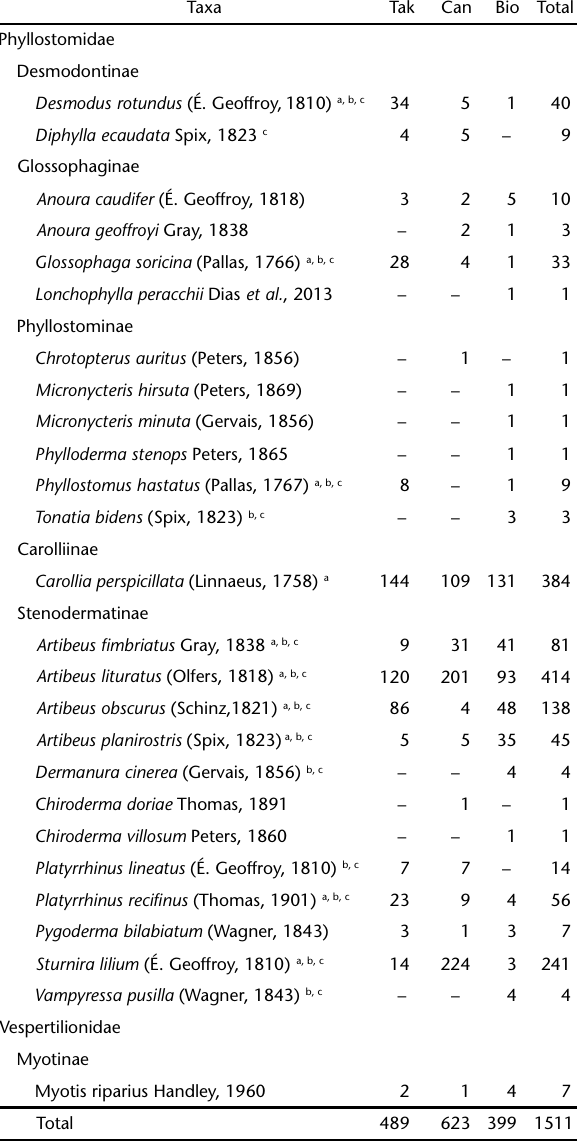
Table I. Number of bats captured in the buffer zone and Tinguá Biological Reserve, state of Rio de Janeiro. a, b, c Difference between abundance of two areas ( (cid:2) 2 > 3.84, p < 0.05). a Takume x Canavarro, b Takume x Bioreserve, c Canavarro x Bioreserve.